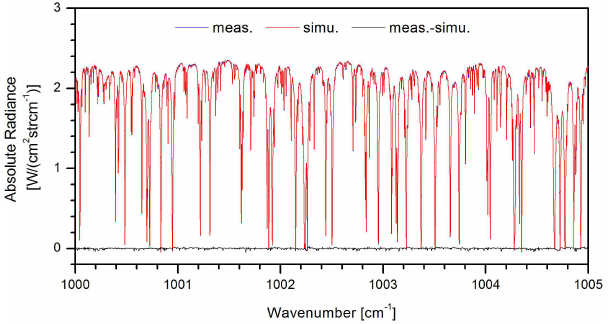
Fig. 1. Spectral microwindow applied for ozone retrievals. Fig. 2. Columns of the FTIR averaging kernels, avks, for retrieved